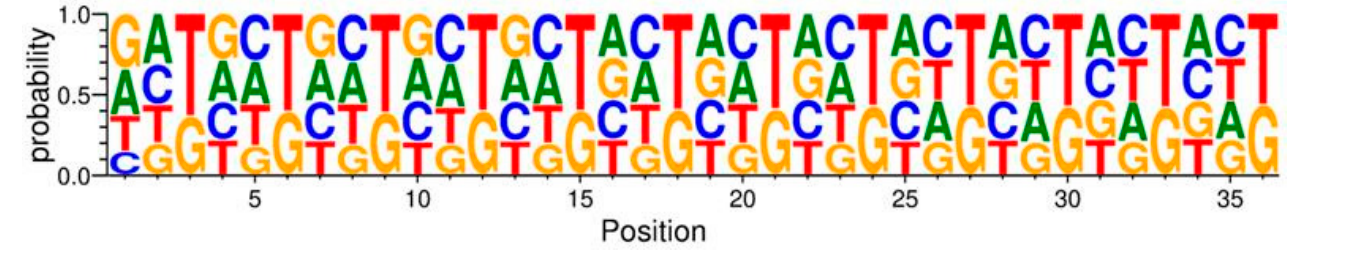
Figure 1. Sequence logo showing the 36 nucleotides encoding the 12-mer variable region with a probability of 0–1. The height of each nucleotide represents the probability of its occurrence in the given position. The sequence logo was generated using the WebLogo 3 library in Python.